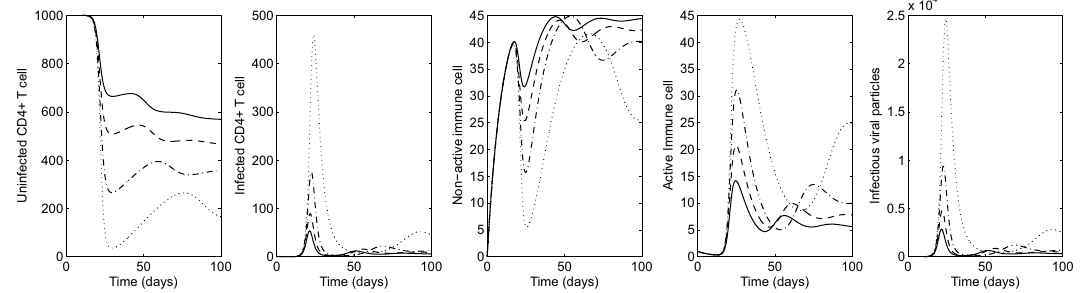
Figure 4. Early-stage HIV dynamics in the absence of controls under four different values of γ ( β = 0.000025 is fixed): γ = 0 (dotted), γ = 0.02 (dash-dot), γ = 0.05 (dashed) and γ = 0.09 (solid).